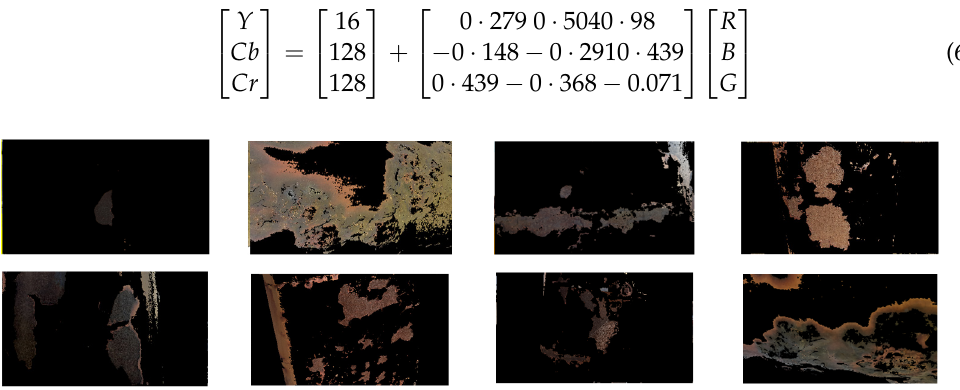
Figure 8. Representative images in YCbCr color space to show corrosion.